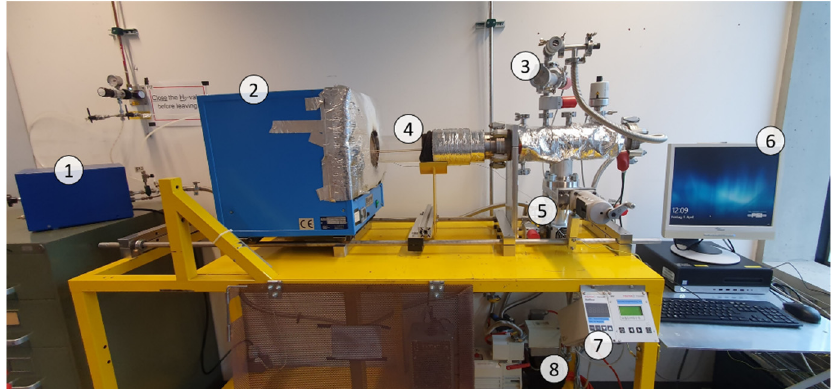
Figure 1. Hydrogenation equipment overview with highlighted main components: (1) hydrogen purifier, (2) furnace, (3) dosing cell, (4) high-vacuum cell, (5) high-vacuum pump, (6) computer monitoring, (7) pressure sensor controller, and (8) low-vacuum pump. The same equipment was used also to induce the hydrogen degassing in high-temperature/high-vacuum conditions. Table 1. Hydrogen pressures recorded during hydrogenation process. Sample S100 was obtained with a single dose. Sample S350 was obtained with three incremental small doses, followed by ho- mogenization and quenching, followed by three subsequent hydrogenation doses.